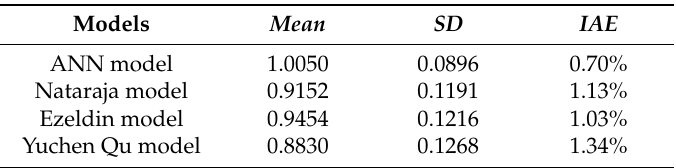
Table 8. The Mean value, standard deviation (SD), and integral absolute error (IAE) of ANN model and analytical